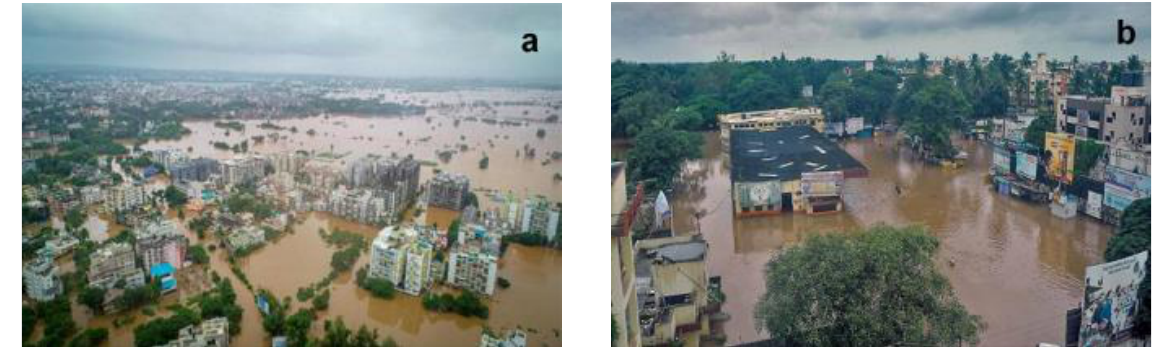
Figure 8. Clips of 2019 flood in the UKB: ( a ) A view of flooded areas due to overflowing Panchganga River in Kolhapur city (Maharashtra) on 7 August 2019 (PTI). Source: Shivam Bodhe/HT photo. Accessed from: http://www.hindustantimes.com on 27 October 2022; ( b ) a view of flooded areas due to overflowing Krishna River in Sangli on 6–7 August 2019 (PTI). Accessed from: http:// indianexpress.com/article on 27 October